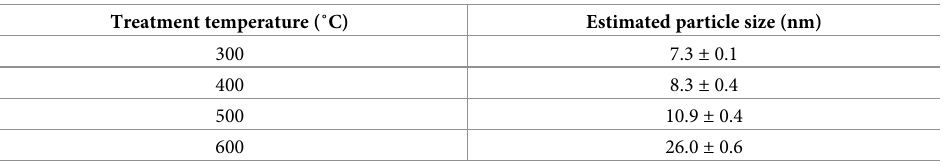
Table 1. Particle sizes of Ag-TiO 2 powder